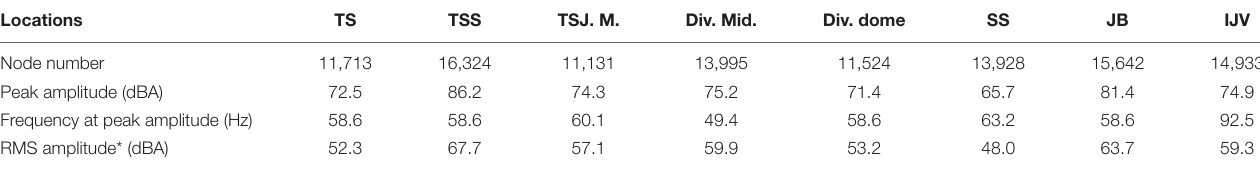
TABLE 5 | Results of CFD hydroacoustic